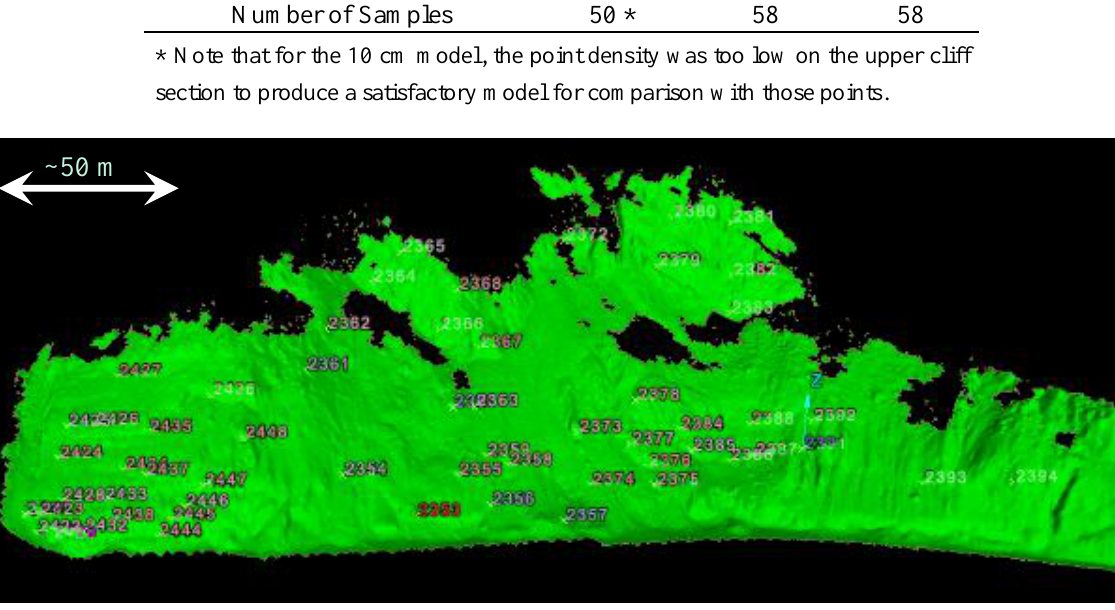
Figure 18. Perspective view of the distribution of comparison points obtained with a total station to the 2012 surface model (25 cm